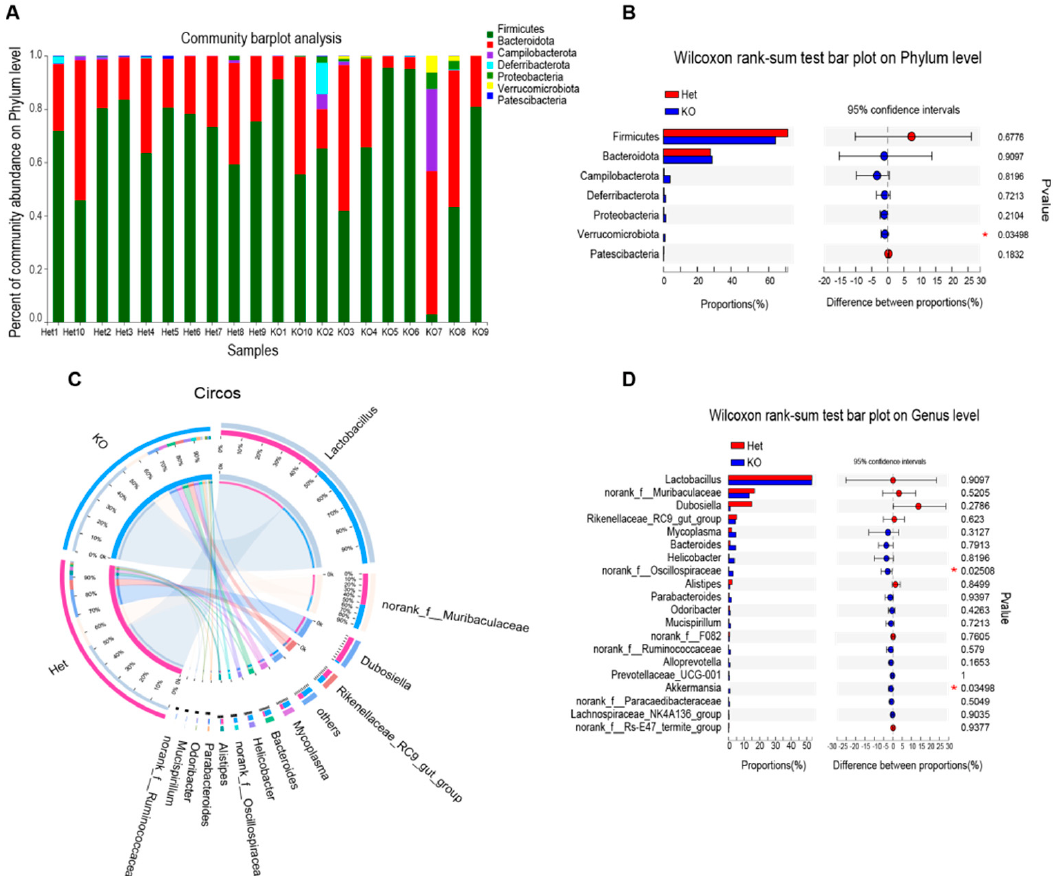
Figure 3. Differentially abundant Phyla and Genera in KO and Het mice. ( A ) Columnar cumulative graph of relative abundance of Phylum species. Others represent the sum of the relative abundances of all the other phyla except for these five phyla in the figure; ( B ) Wilcoxon rank-sum test bar plot on Phylum level. Verrucomicrobia in the KO group has a significant increase; ( C ) the relationship between samples and the species at the Genus level. The small semicircle (left half-circle) indicates the composition of the species in the sample. The color of the outer ribbon represents which group it comes from, the color of the inner ribbon represents the species, and the length represents the relative abundance in the corresponding sample; the large semicircle (the right half circle) represents the distribution of species in different samples at the taxonomic level. The outer ribbon represents the species. The inner ribbon color represents different groups. The length represents the proportion of distribution in a species. ( D ) Wilcoxon rank-sum test bar plot on the genus level. The G_ Akkermansia and G_ Oscillospiraceae increased significantly in the KO group. * p < 0.05. KO: Knockout; Het: Heterozygote. According to genus-level profiling, OTU could be assigned to 34 individual genera. The top five predominant genera in the Het group were Lactobacillus (53.35%), Muribacu- laceae (16.55%), Dubosiella (14.85%), Rikenellaceae (5.14%), and Mycoplasma (1.993%). How- ever, in the KO group, the rankings and proportions of the top five dominant bacteria changed and were Lactobacillus (53.25%), Muribaculaceae (13.22%), Rikenellaceae (4.327%), Mycoplasma (4.602%), and Bacteroides (4.474%) (Figure 3C). Wilcoxon rank sum tests (Figure 3D) showed that the abundances of Oscillospiraceae and Akkermansia in the KO group were significantly higher than those in the control group. A heat map of different genera abun- dances for each sample is shown in Supplementary Figure S3B. 3.4. The Significant Different Species between Gene Deletion Mice and Heterozygous Mice LDA Effect Size (LEfSe) is a kind of software used to reveal the characteristics of ge- nomes. First, non-parametric factorial Kruskal–Wallis (KW) sum-rank test was used to detect significant abundance differences. And then linear discriminant analysis (LDA)